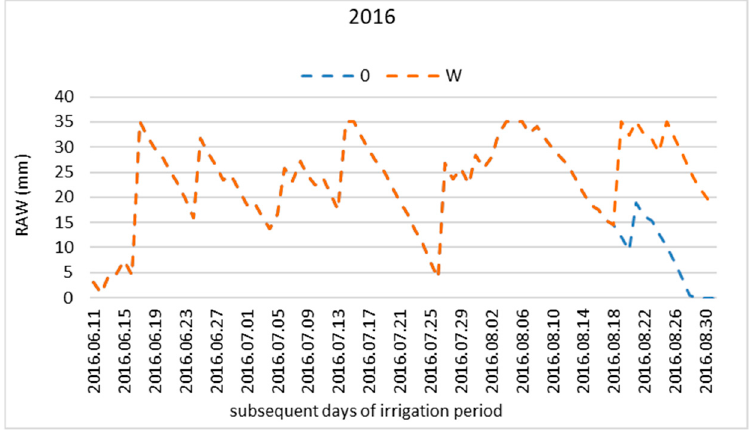
Figure 3. The balance of water readily available to plants in the soil layer with controlled moisture in the period from 11 June to 31 August 2016 (wet season) (0–rainfed, W–irrigation).